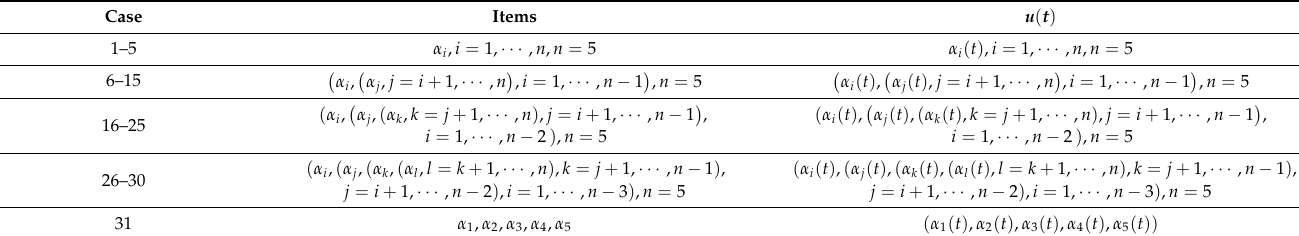
Table 2. Control parameters, optimal control variables.